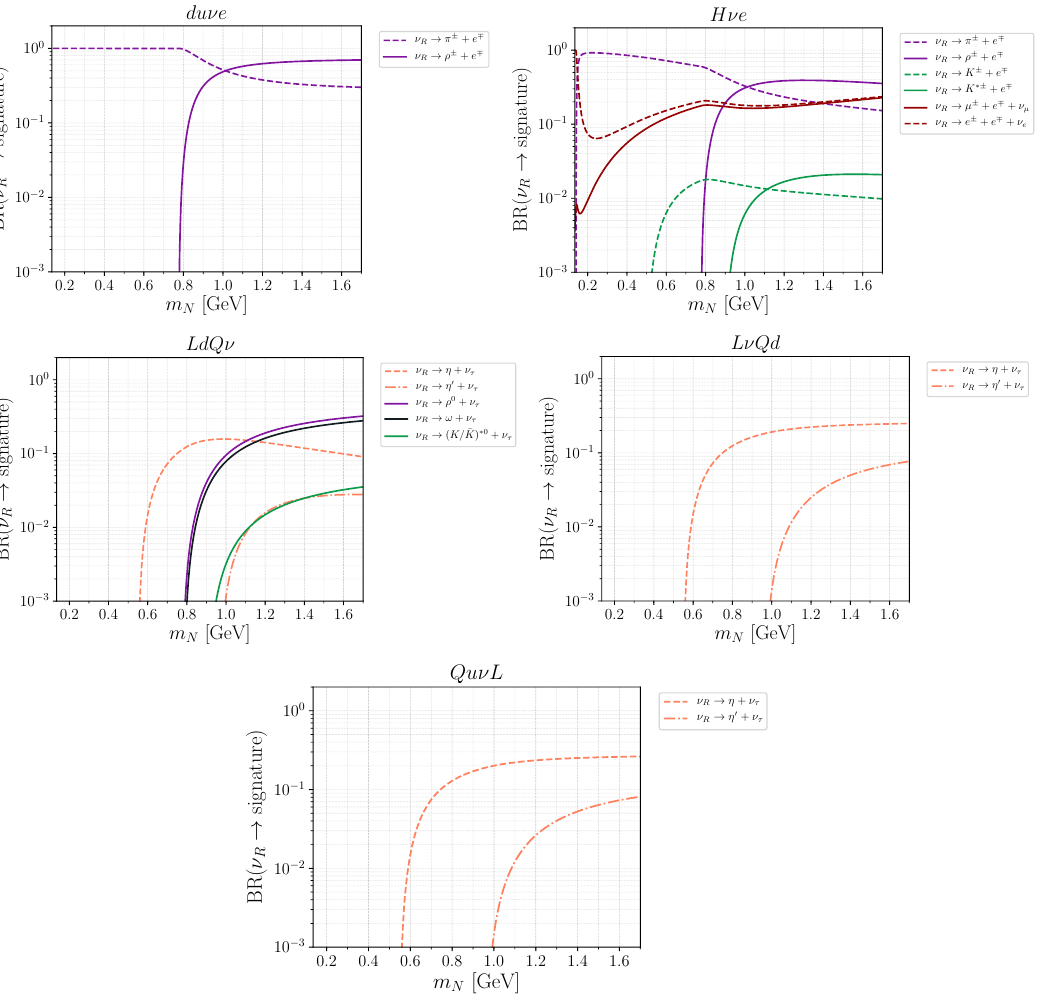
Figure 6 . Branching ratios of visible decay modes for the sterile neutrino in ν SMEFT scenarios.